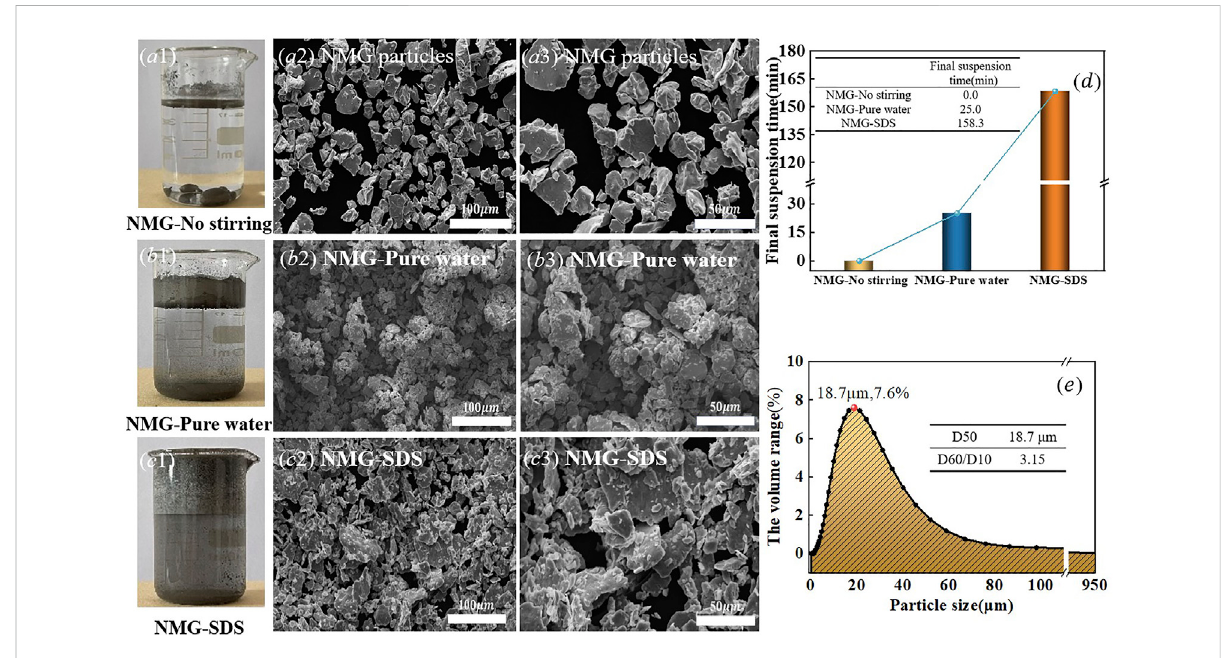
FIGURE 2 Characteristic test results of NMG micro/nano fl uids.